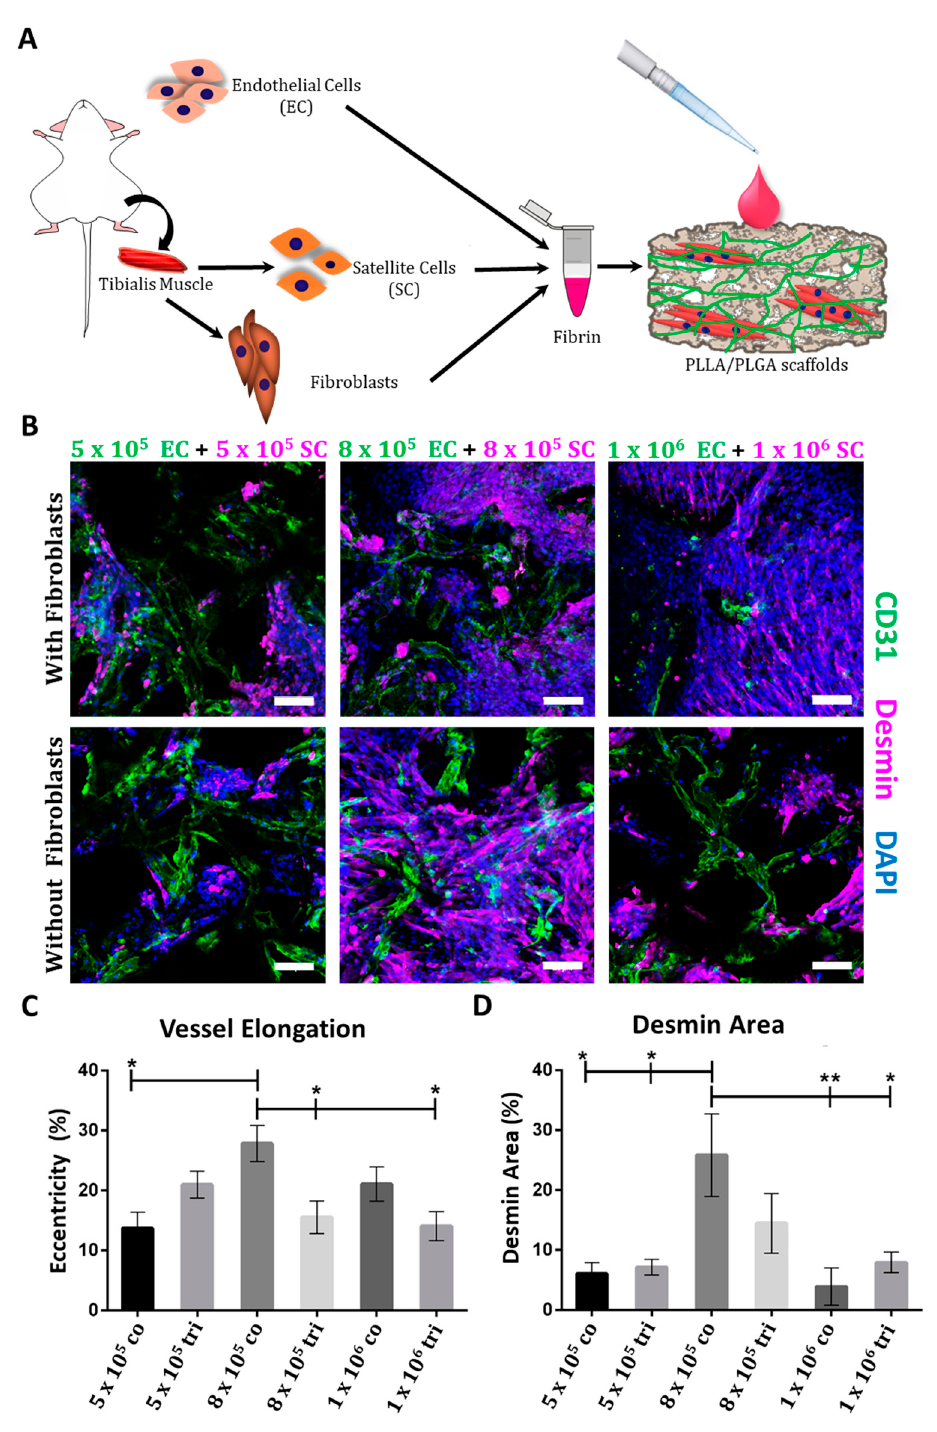
Figure 1. Multicellular culturing strategy. ( A ) A schematic presentation of the cell isolation procedure and the multicellular culture combinations examined. ( B ) Representative confocal images of whole-mount immunofluorescent sca ff olds populated with endothelial cells (ECs) and satellite cells (SCs), with or without fibroblasts, 14 days post-seeding. ECs are stained in green, desmin-positive